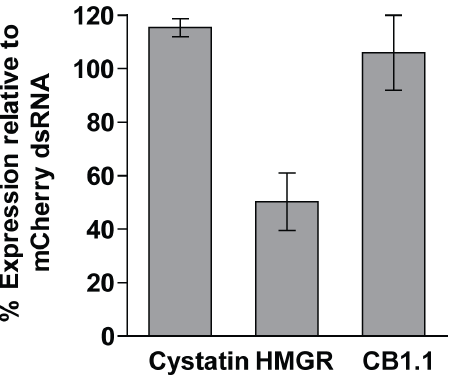
Figure 3. RNAi of SmHMGR is selective for the target. Newly transformed somules were incubated with HMGR- or mCherry-dsRNA for seven days as described in the text. RNAi was measured by qRT-PCR and data expressed relative to data for mCherry dsRNA controls. To assess for potential off-targeting by HMGR-dsRNA, the expression of a S. mansoni cysteine protease inhibitor, cystatin (Cys: AY334553.1), and the gut-associated cysteine protease, cathepsin B1.1 (AJ506157), was also measured. Bars represent means 6 S.D. across two independent experiments each in duplicate. Using Student’s t -test, gene suppression in the HMGR-dsRNA treated sample is significantly different from the mCherry controls ( p , 0.01).